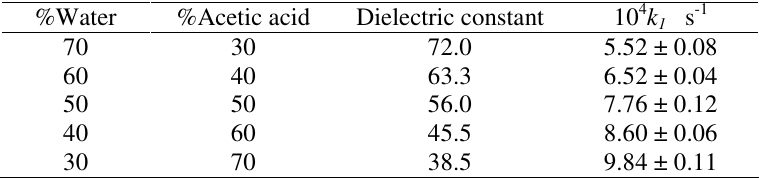
Table 2. Effect of varying solvent polarity on the rate of reaction at 303 K [Met] = 2.0 x 10